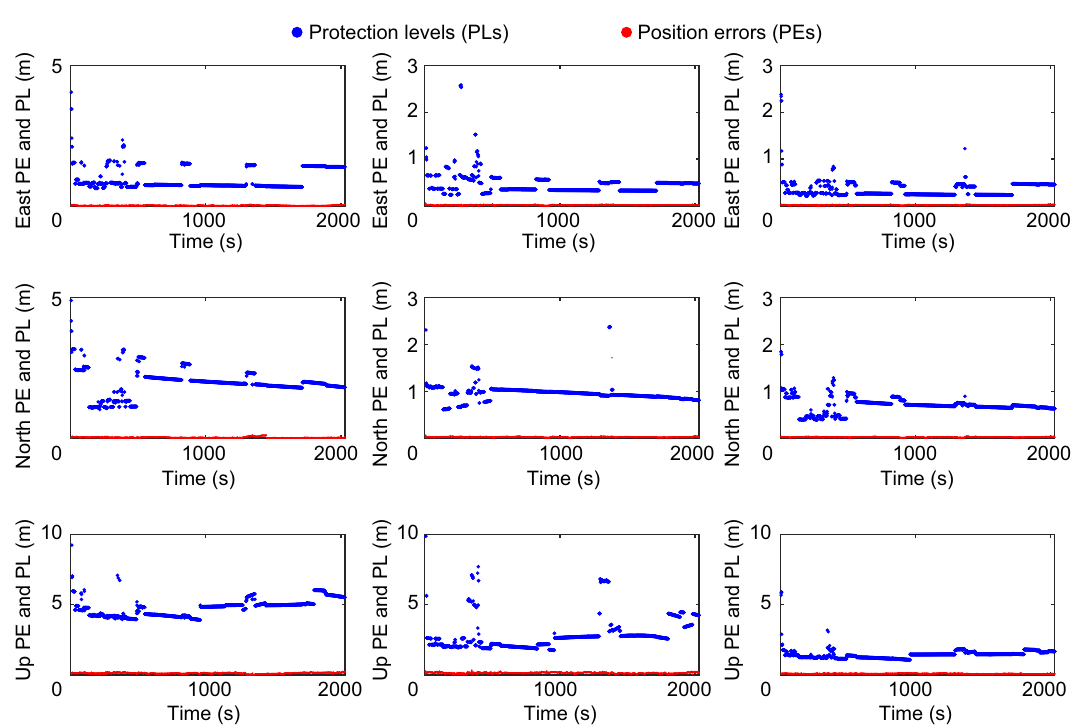
Fig. 9 Performance of the second kinematic dataset for PPP-WAR model with regional atmospheric corrections (left), PPP-AR model (middle), and PPP-RTK model (right)